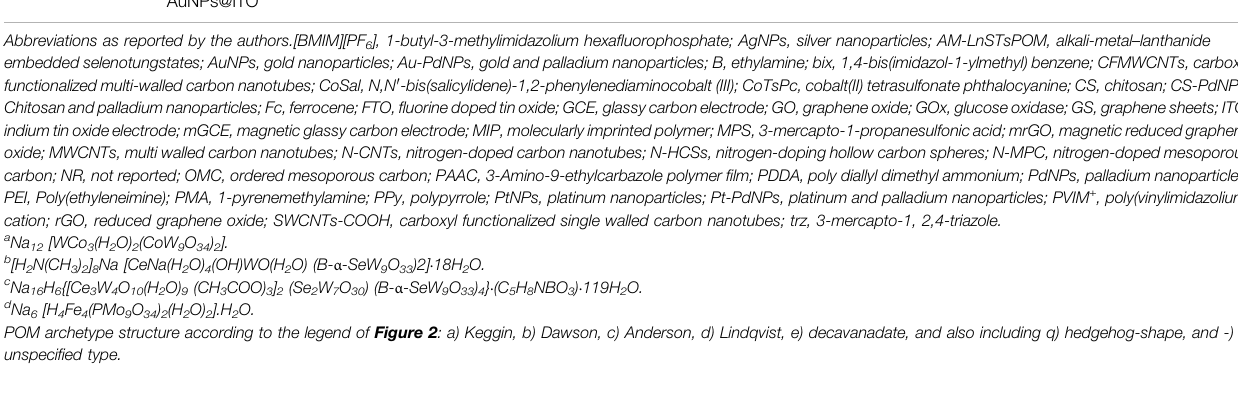
(MIP) for the electrochemical detection of DIA molecule in fruit